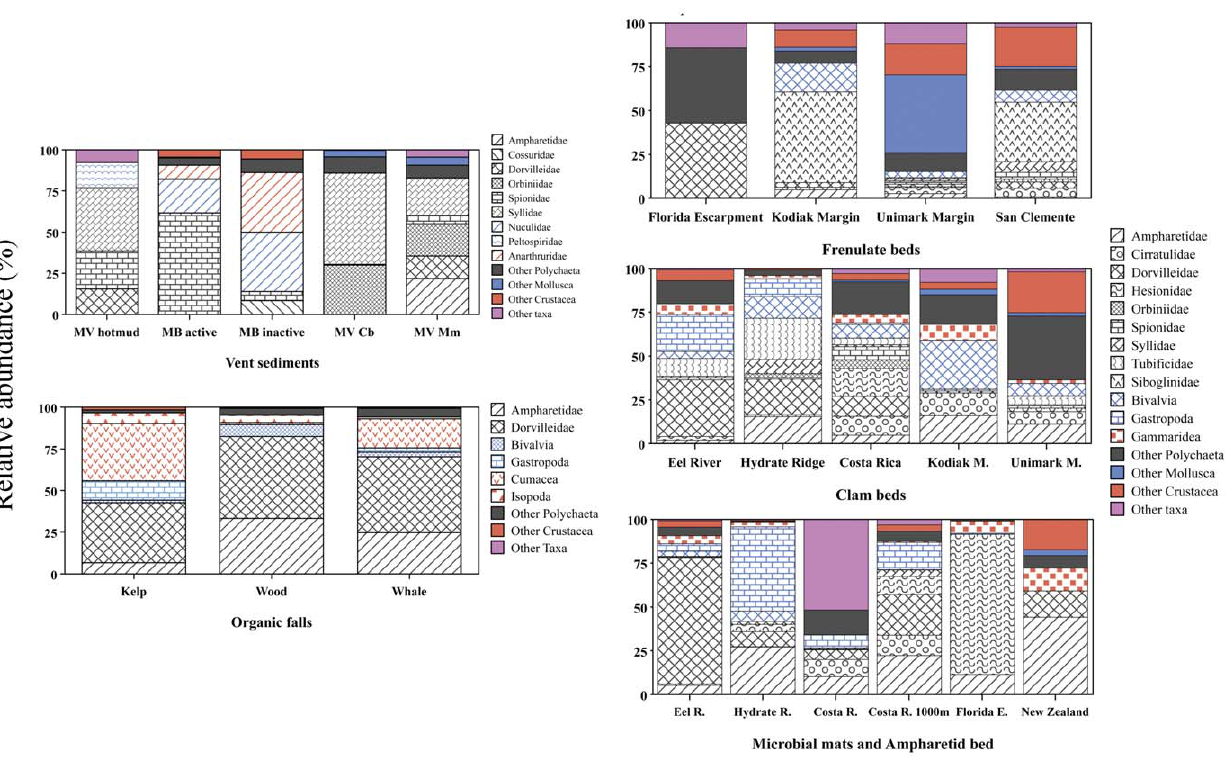
Figure 3. Macrofaunal composition within habitats in Vent, Seep and Organic-Fall ecosystems. Values are relative abundance (%) of all samples within each habitat/site. Color-code: Polychaetes (patterns in black); Mollusks (in blue); Crustaceans (in red) and Other taxa (purple). Ampharetid beds represented only in New Zealand.